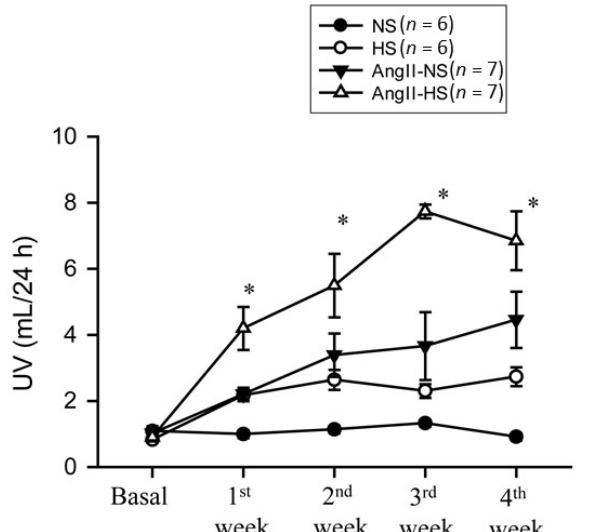
Figure 3. Urine flow (UV) responses to chronic AngII (25 ng/min) infusion in mice given NS (NS; 0.3% NaCl) and HS (HS; 4% NaCl) containing diets; * : P < 0.05 vs. AngII + N